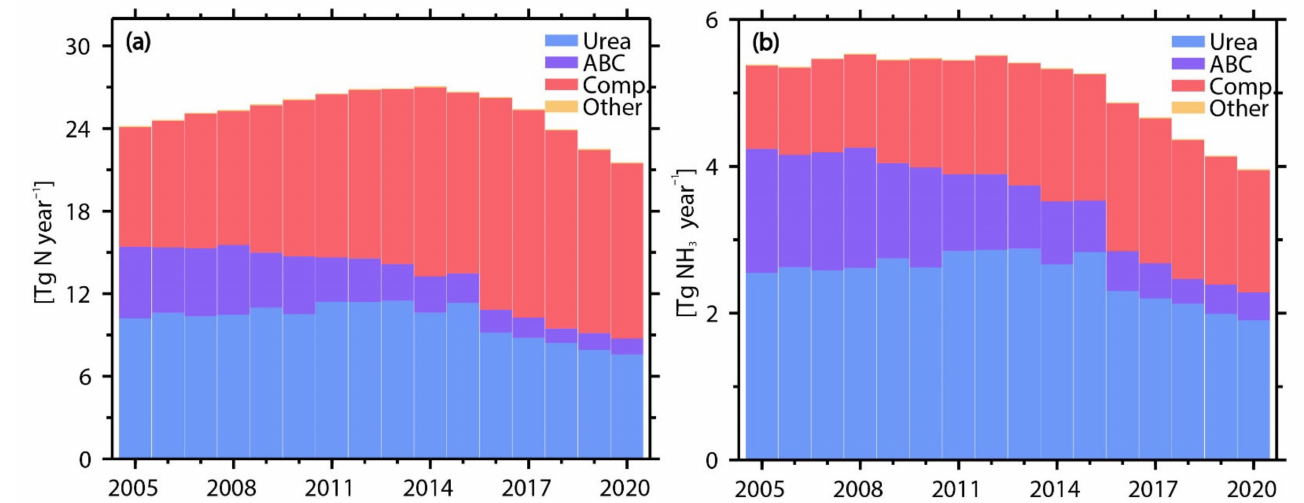
Figure 1. Interannual variation in ( a ) synthetic nitrogen fertilizer application and ( b ) resulting NH 3 emis- sions in China from 2005–2020; synthetic nitrogen fertilizer is categorized as urea (blue bars), ABC (am- monium bicarbonate, purple bars), Comp. (compound fertilizer, including NK—nitrogen + potassium, NP—nitrogen + phosphorus and NPK—nitrogen + phosphorus +potassium, red bars) and other (AS—ammonium sulfate, AN—ammonium nitrate, and others, yellow